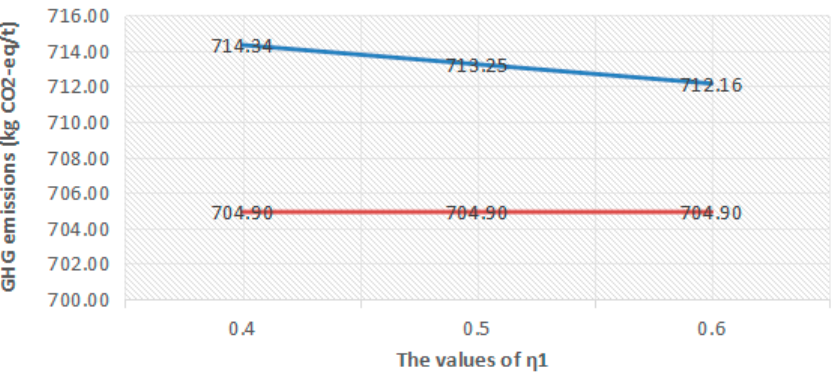
Figure 3. The influence of the ratio of collection centers on total GHG emissions and total GHG savings.